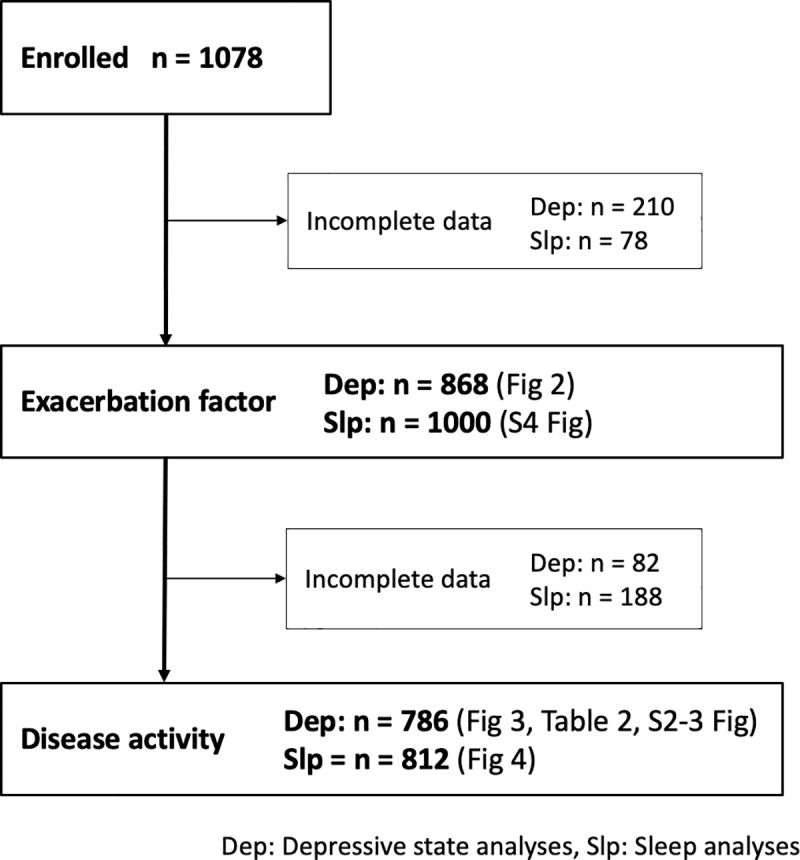
Study flow chart.